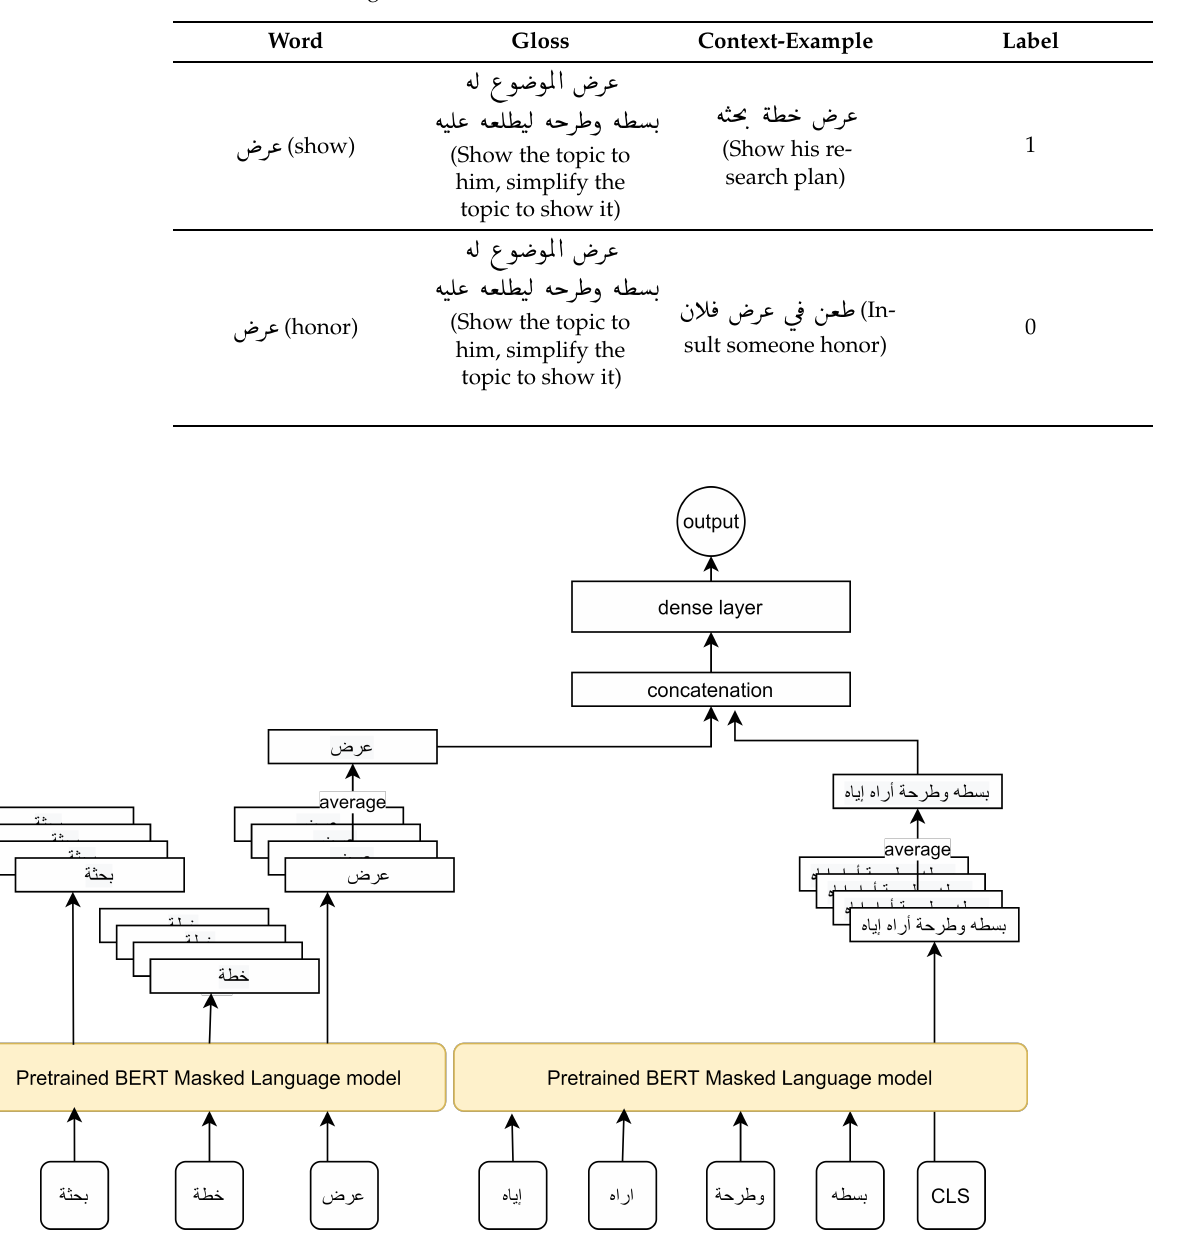
Table 4. Our novel dataset consists of 31 K records, 15,549 positive examples, and 15,549